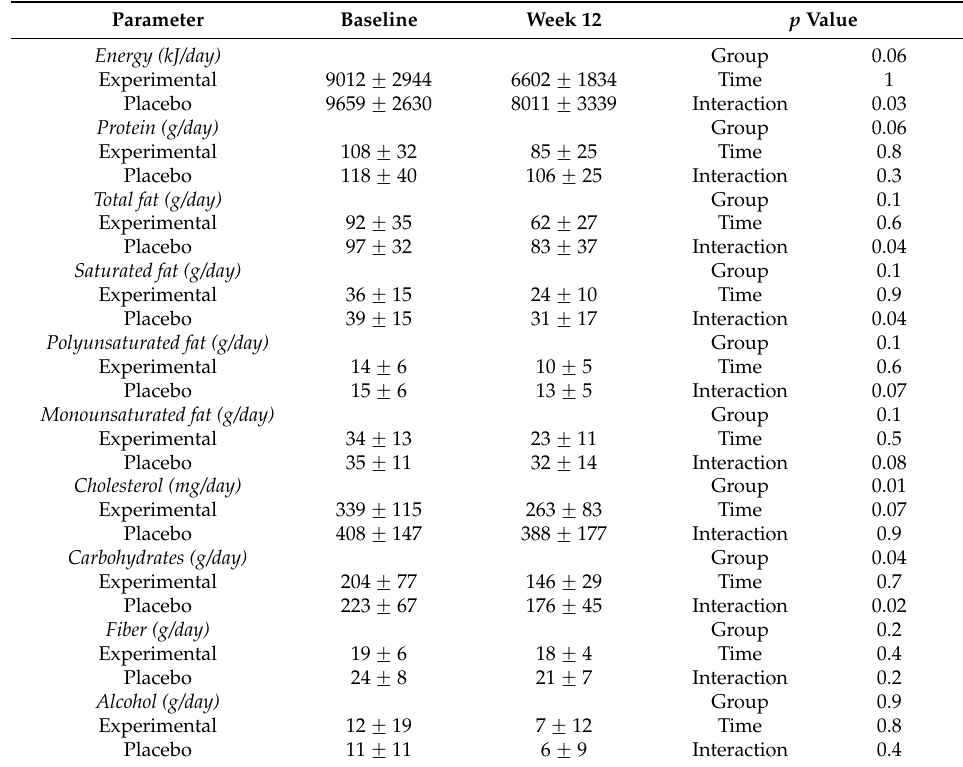
Table 5. Dietary intake of energy and nutrients reported in FFQ at baseline and week